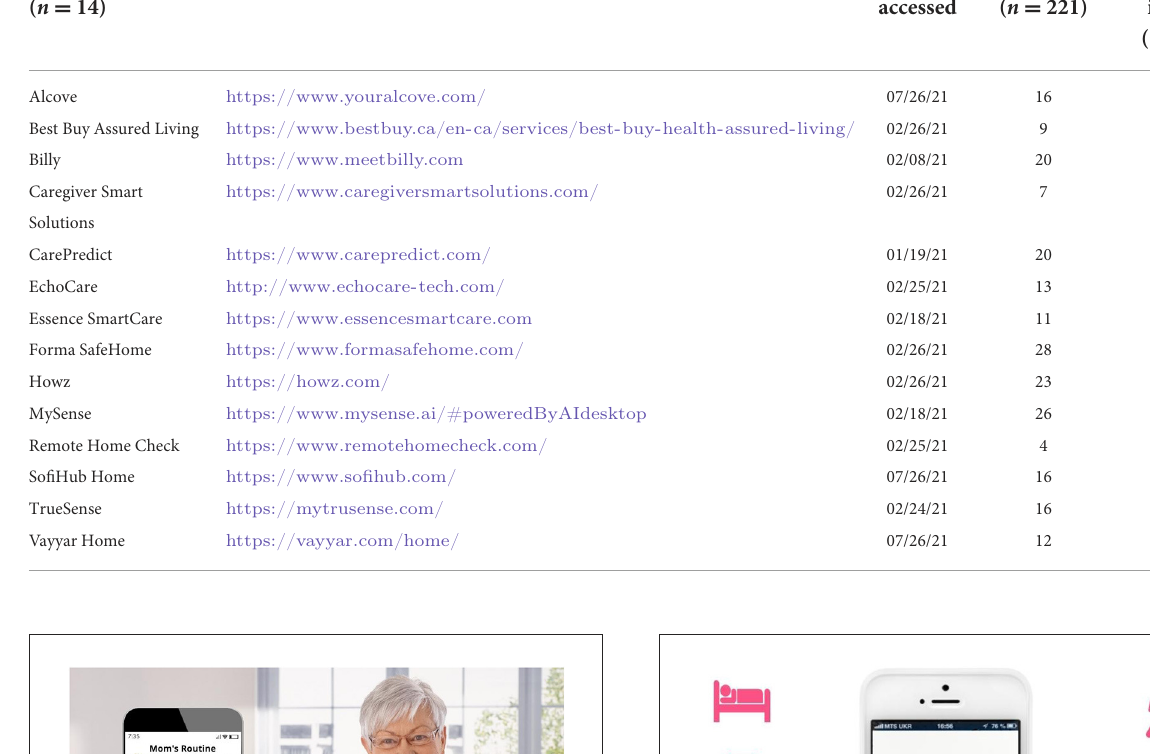
TABLE 1 Company/product name, website, access date, total images in initial sample, and total images visualizing data. Company/product